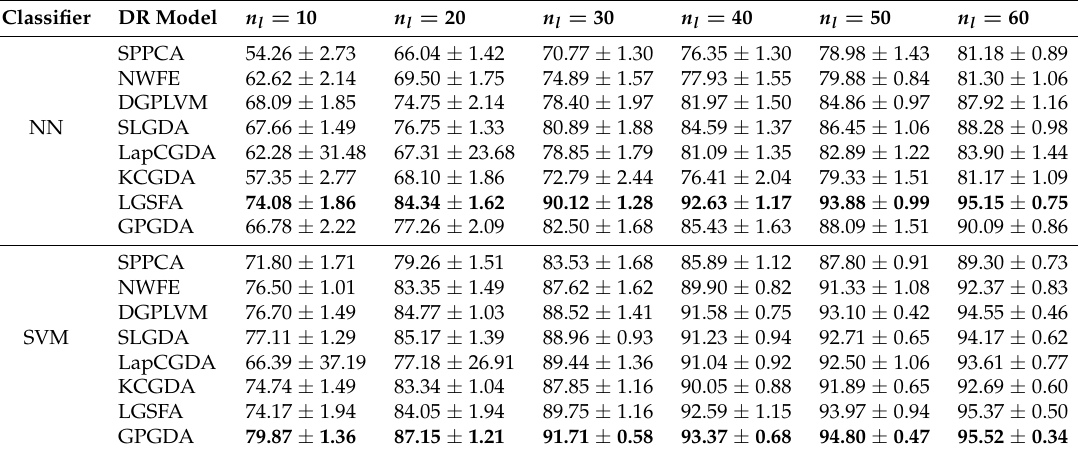
Table 5. Classification results with different amounts of training data on the Indian pines data (OA ± STD (%)).